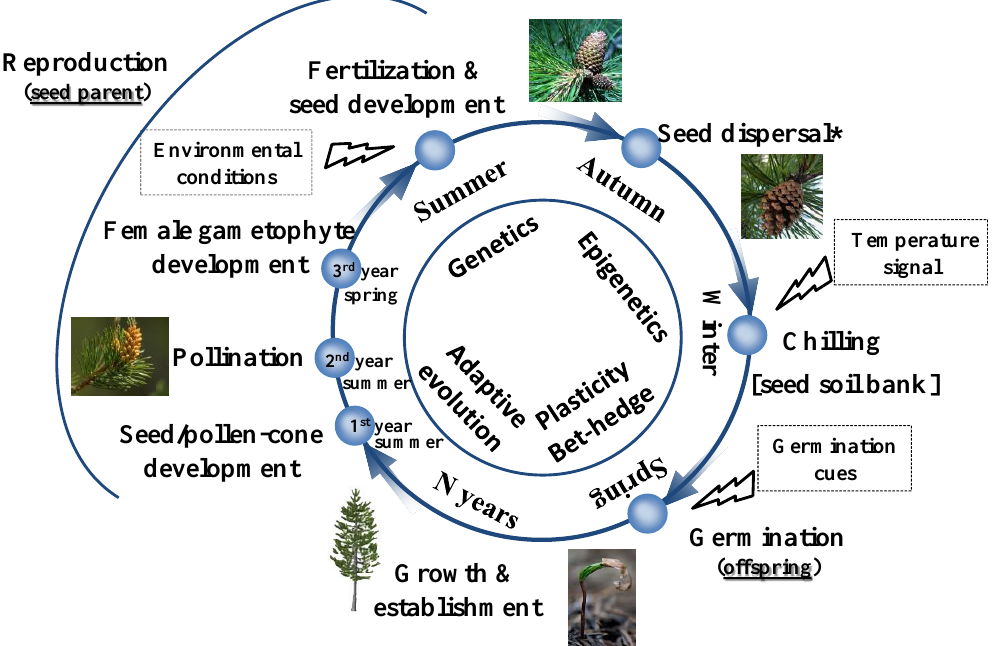
Figure 6. Important environment stages and intrinsic mechanisms in the life cycle of lodgepole pine for life-history traits. Note: (1) seed dispersal may not occur in the following season and it may take years until the cone drops and seeds release in nature; (2) the reproduction cycle of (lodgepole) pine undergoes 3years, that is, seed/pollen cone initiation (August, September, October) → dormant (November, De- cember, January, February, March) → pollen development (April, May) → pollination (June) → female gametophyte development (July, Au- gust) → dormant (September, October, November, December, January, February, March, April) → female gametophyte development (May,